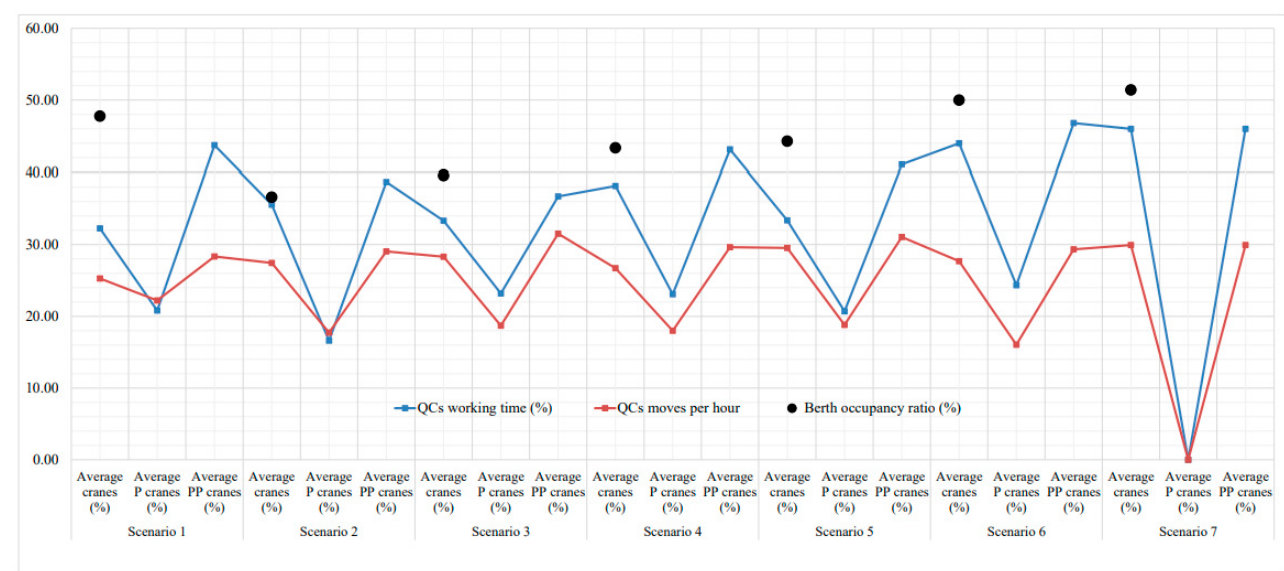
Figure 5. Graphical view of the berth results.